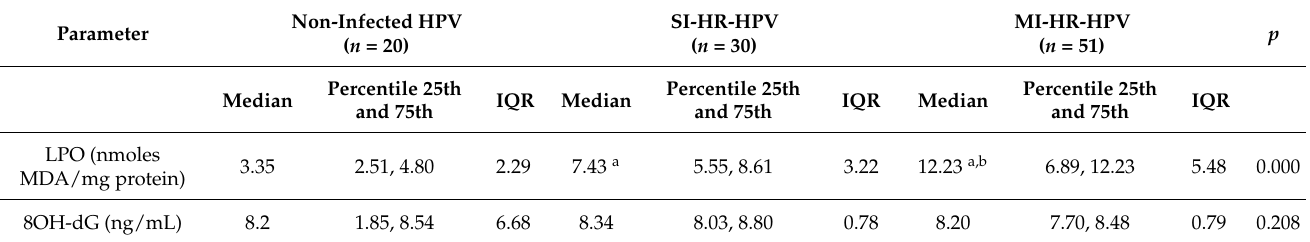
Table 3. Oxidative stress biomarkers in semen samples.